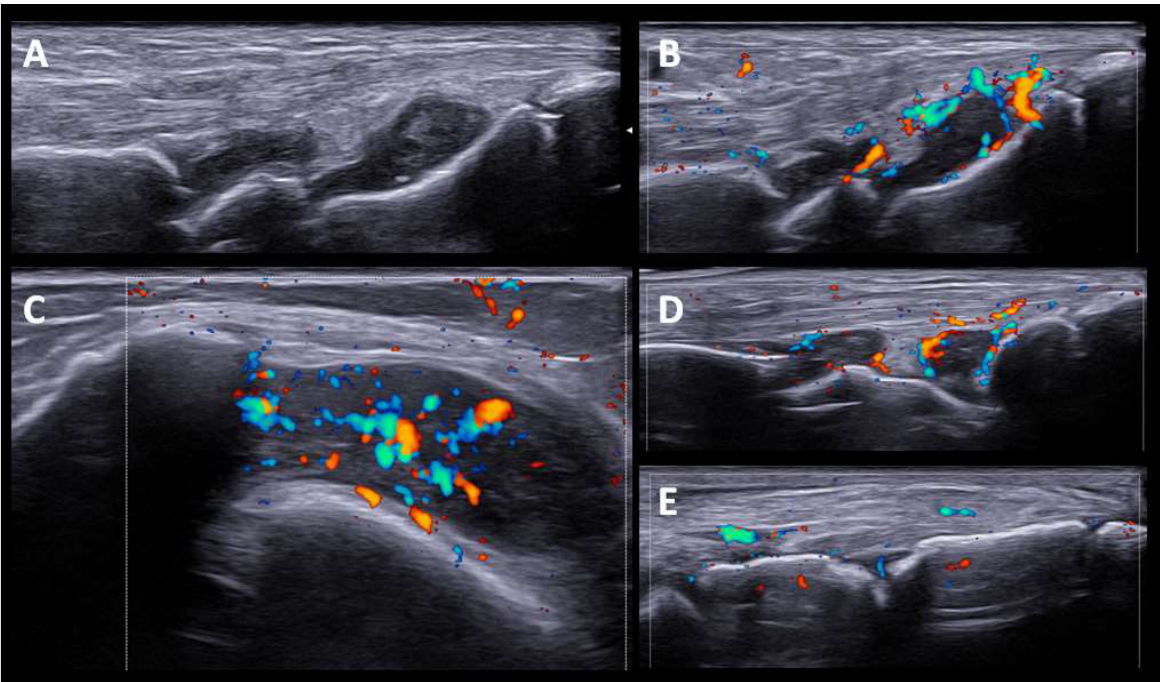
Figure 1. US findings in RA-like pattern. ( A , B ). Carpal joint with synovial hypertrophy grade 2 and power doppler signal grade 2. ( C ). Knee suprapatellar recess shows synovial hypertrophy grade 3, and Power Doppler signal grade 2. ( D , E ). Tibiotalar, subtalar and tarsal joints with moderate synovitis and Power Doppler signal grade 2.